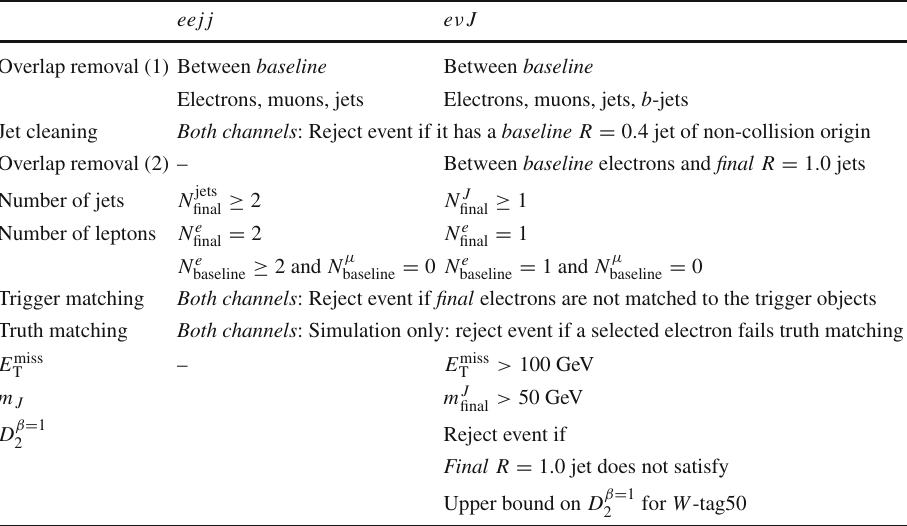
eejj Overlap removal (1) Between